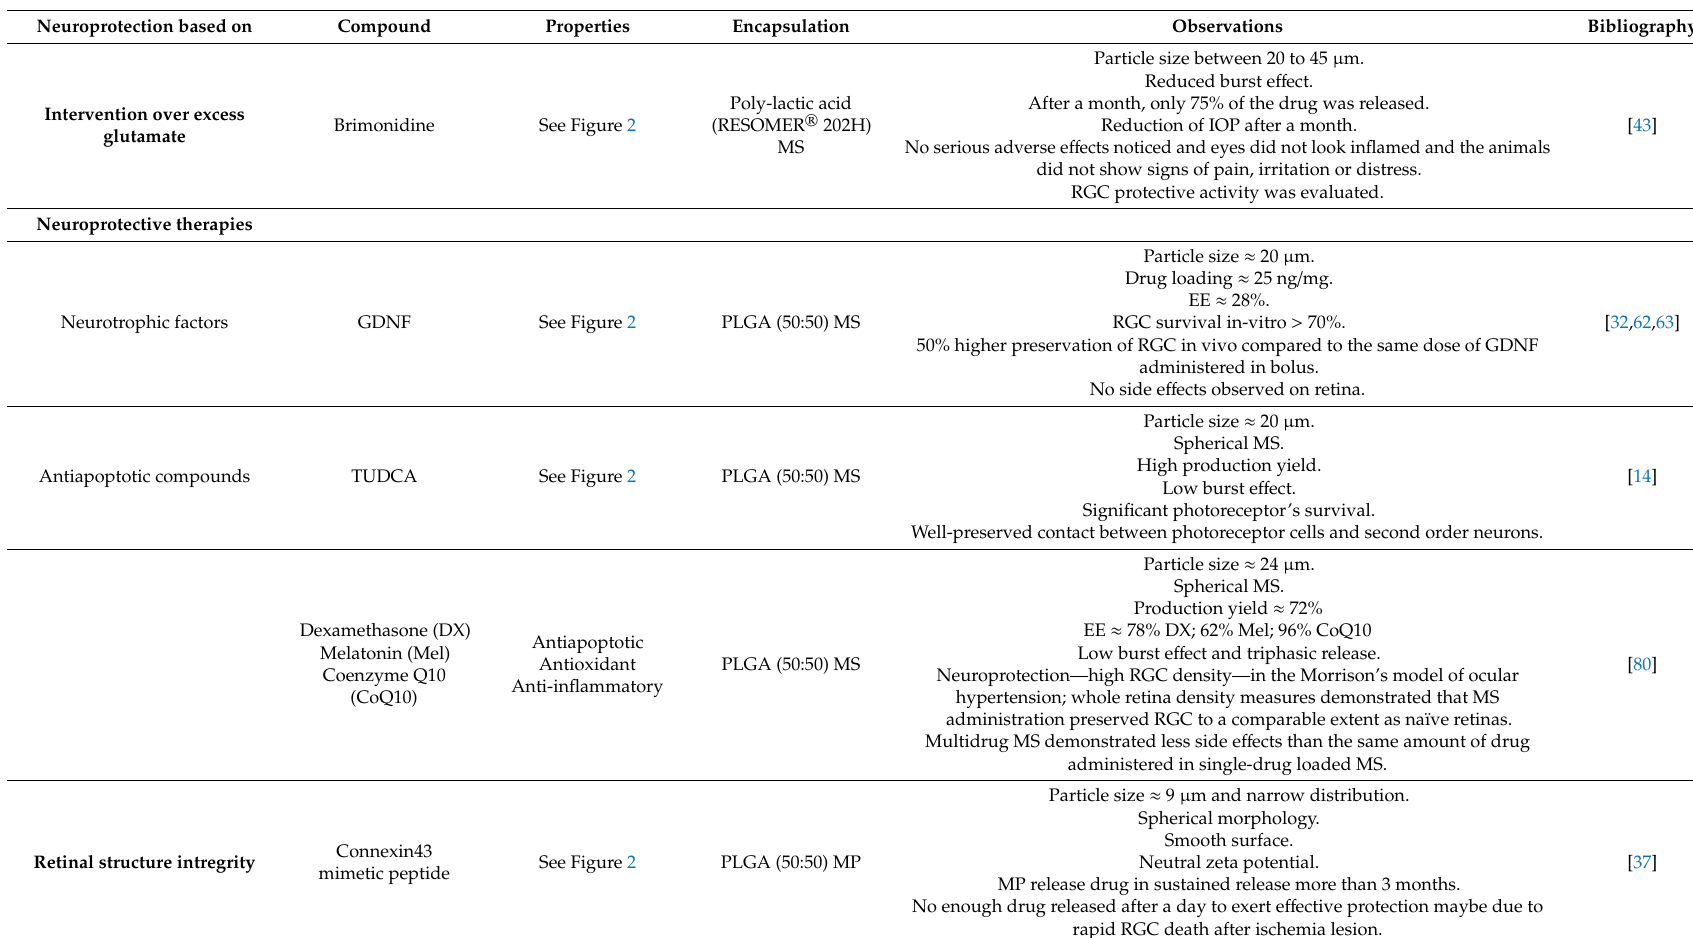
Table 2. Alternatives for ocular neuroprotection where microparticles (MP) have been evaluated. The compound tested and its properties as well as the most relevant results obtained are